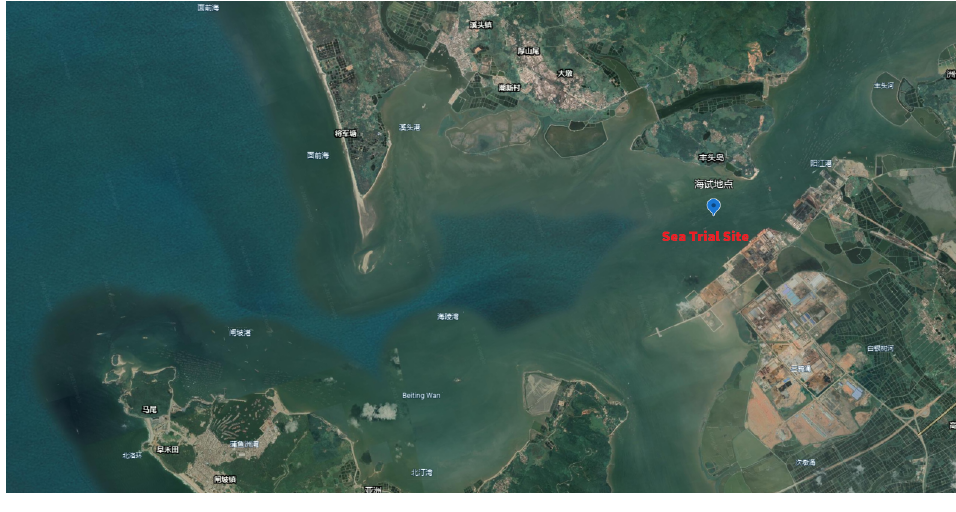
Figure 14. Sea trial site.